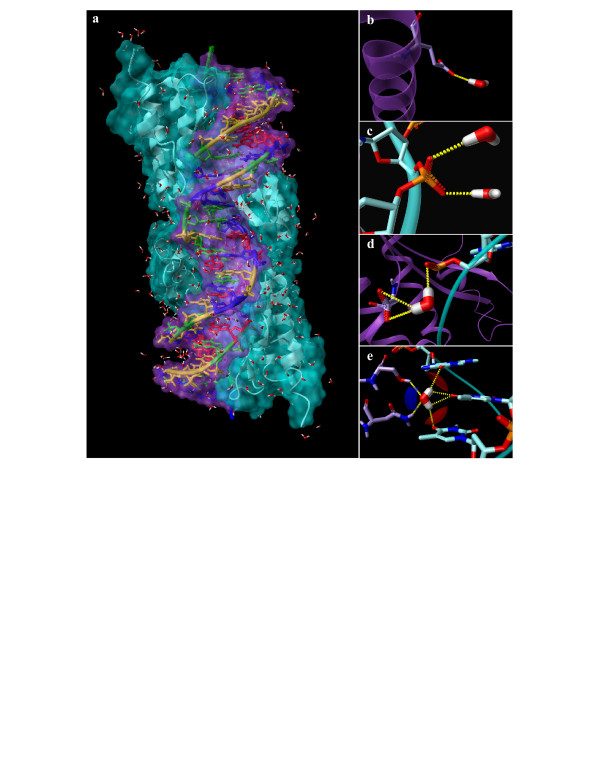
Three-dimensional structure representation of Homing endonuclease I-crei complex (1g9y), using display features of the Lithium software package [75]. a) Overall view of the complex where the protein is displayed in ribbon/tube style and the DNA is represented in color-coded ribbons: red for adenine (A), blue for cytosine (C), green for guanine (G), and yellow for thymine (T). b) Water molecule hydrating a negatively-charged amino acid side-chain. c) Water molecule hydrating a DNA phosphate group. d) Water molecule screening the repulsive interaction between an Asp side-chain and a DNA phosphate. e) Water molecule located at the complex interface mediating specific amino acid-base interactions.